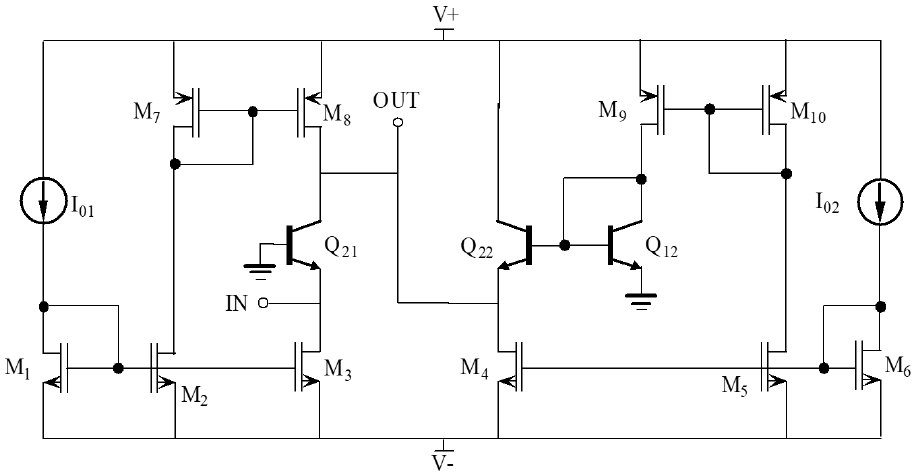
Figure 8. Schematic of the proposed RF-VGA.